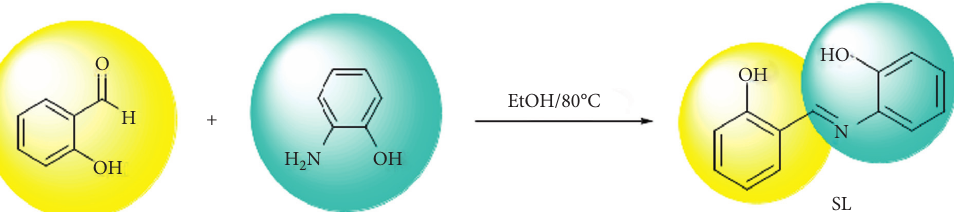
Scheme 2: Chemical reaction of Schiff base synthesis.